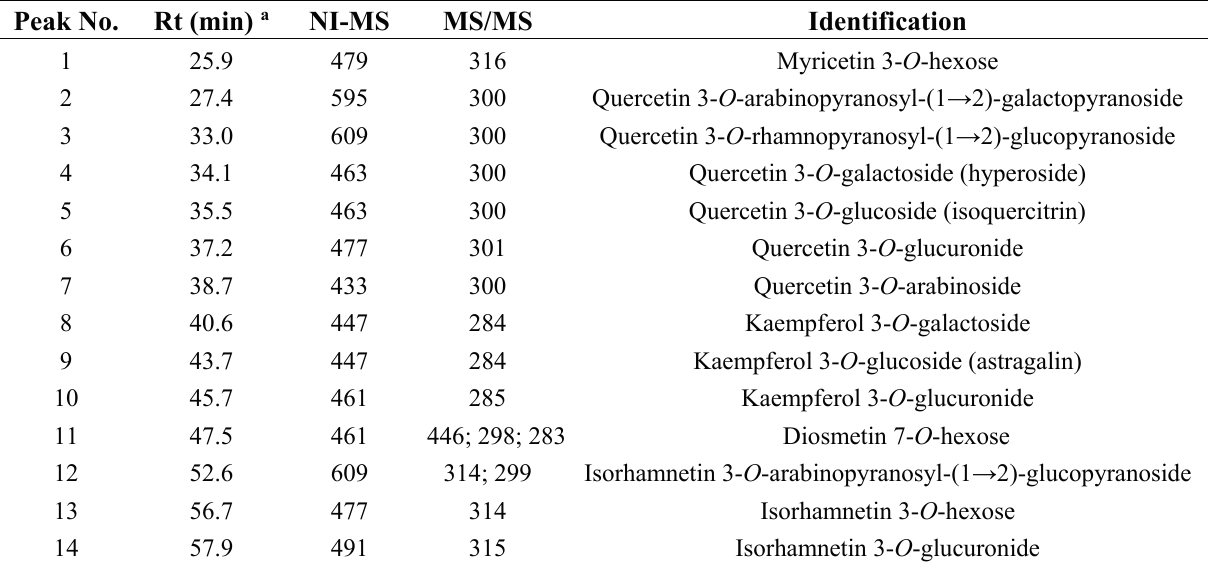
Table 1. Identification of flavonoids in fraction II of lotus leaves by LC-MS/MS. Peak No.